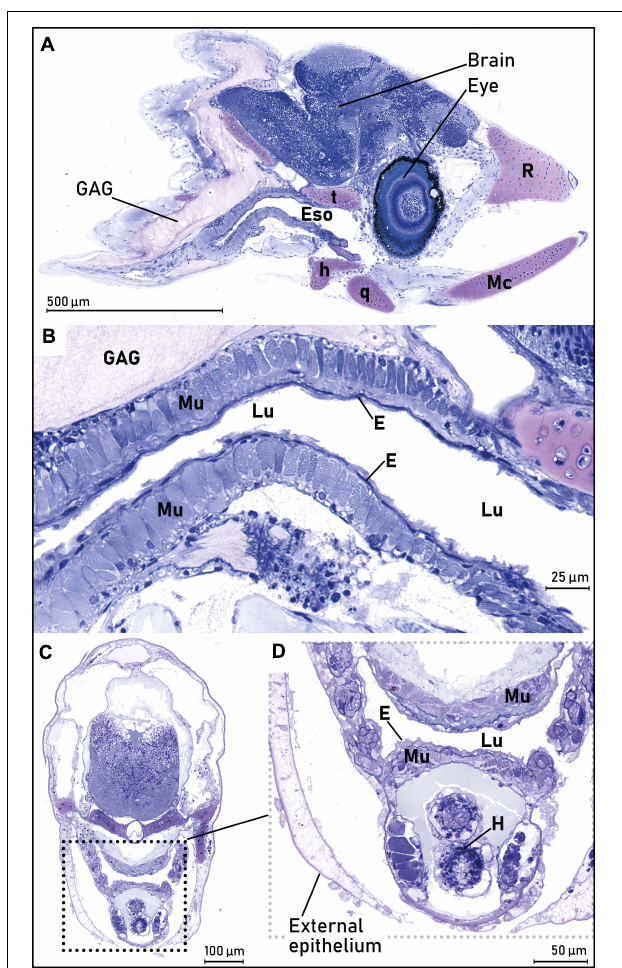
FIGURE 5 | The mouth/pharynx of the European eel ( Anguilla anguilla ) leptocephalus larvae. (A) Longitudinal section of the larval head, illustrating the mouth/pharynx and esophagus (Eso) where the stratified squamous epithelium (E) covered a layer of striated muscle (Mu), visible from behind the eyes. The cartilage structure of the larval jaw bones (Mc, q, r, t) and the anterior part of the glycosaminoglycan (GAG) layer is also visible. (B) Higher magnification of same larval section as in (A) , with more details of the epithelium structure. The striated squamous epithelium (E) covered a layer of striated muscle (Mu), visible from behind the eyes. The cartilage structure of the larval jaw bones (Me, q, r, t) and the anterior part of the glycosaminoglycan (GAG) layer is also visible. (C) Overview of sectional area of pharynx. Cross section of eel larval head, through the heart (behind the eyes). The squared dotted lines illustrate the esophagus shown in (D) . (D) Close up of esophagus/pharynx, showing the rough, squamous epithelium (E) and the striated muscle (Mu). Abbreviations: E, epithelium; Eso, esophagus; GAG, glycosaminoglycan; H, heart; h, hyomandibulare; Lu, lumen; Mc, Meckel’s cartilage; Mu, striated muscle; q, quadratum; r, rostrum; t, trabeculum